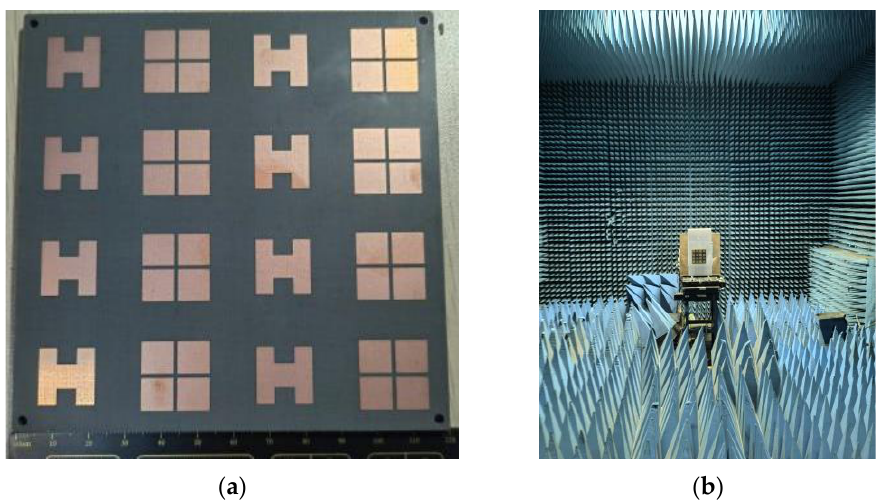
Figure 22. Fabricated prototype of the proposed array antenna. ( a ) Structural diagram; ( b ) radiation far-field patterns test scene.